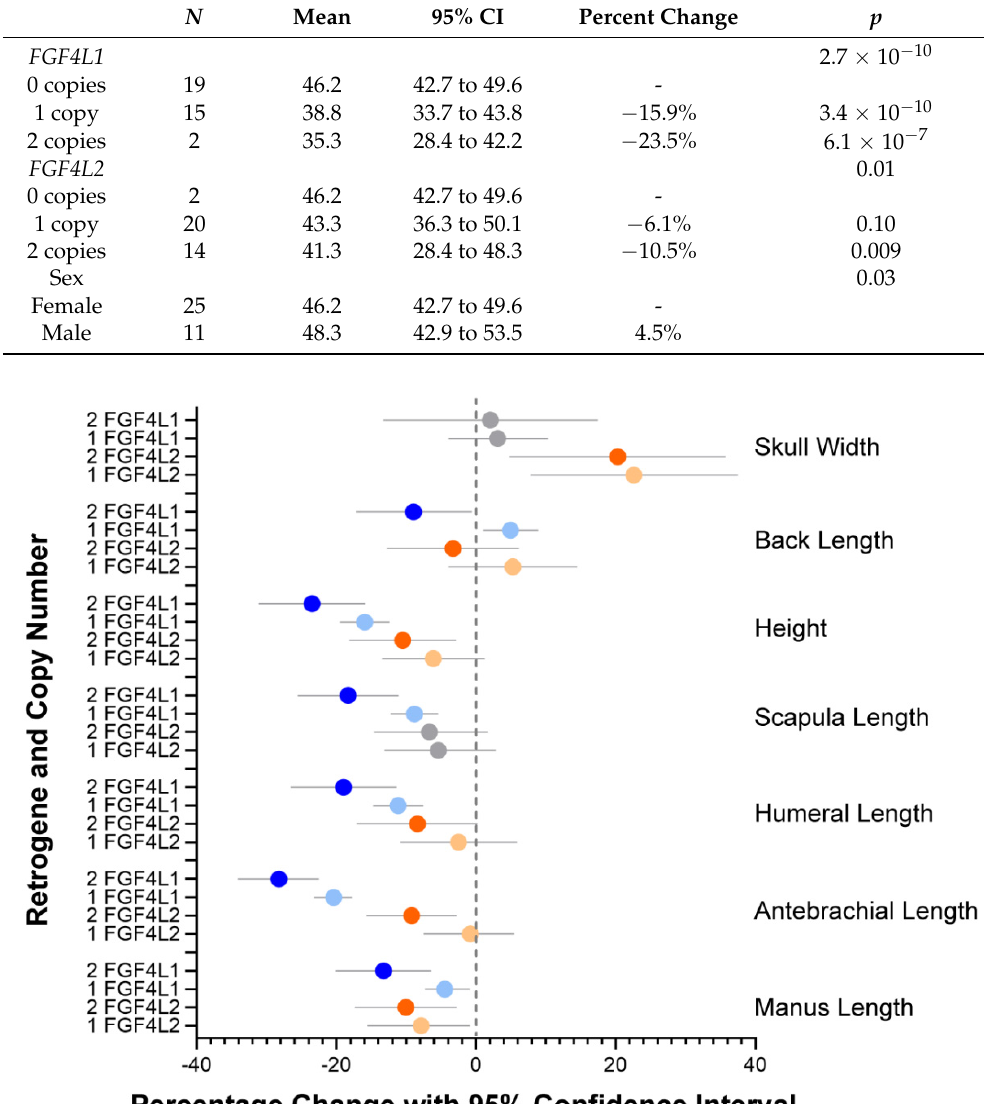
Table 2. Multivariable analysis of height at the shoulders in cm in 36 Schweizer Niederlaufhund dogs.